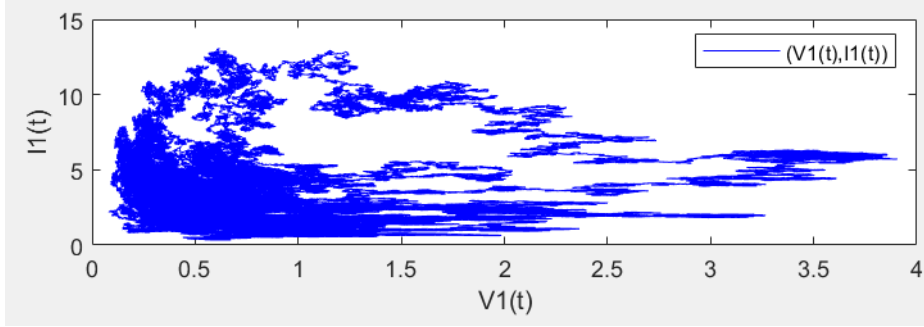
Figure 11. Phase portrait of model (4).